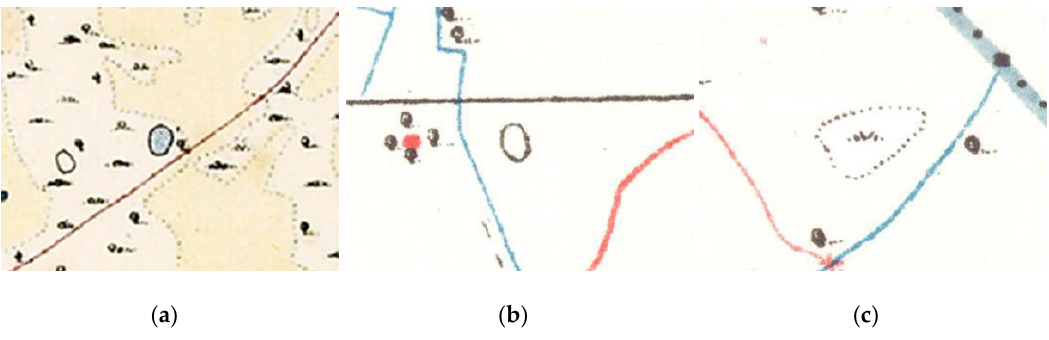
Figure 10. ( a ) Full pond; ( b ) Dry pond; ( c ) Dotted line feature (Images courtesy of Cambridge University Library).